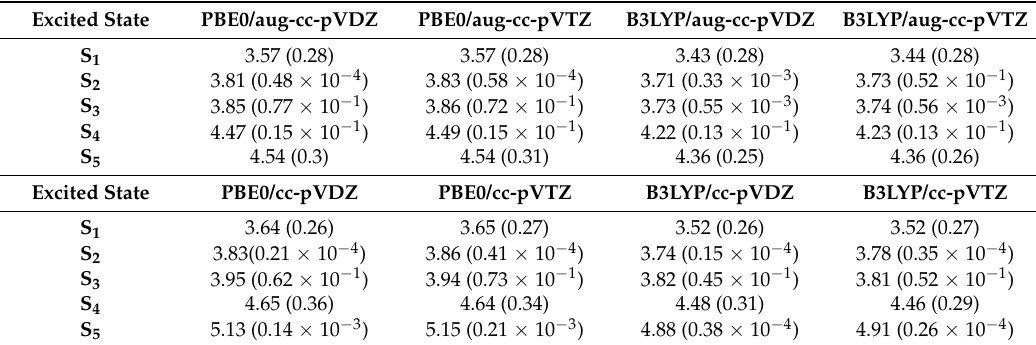
Table 2. Vertical excitation energies in eV (oscillator strengths are given in parentheses) of Laurdan in the water environment modeled by implicit COSMO model calculated employing various TD-DFT functionals and basis sets.